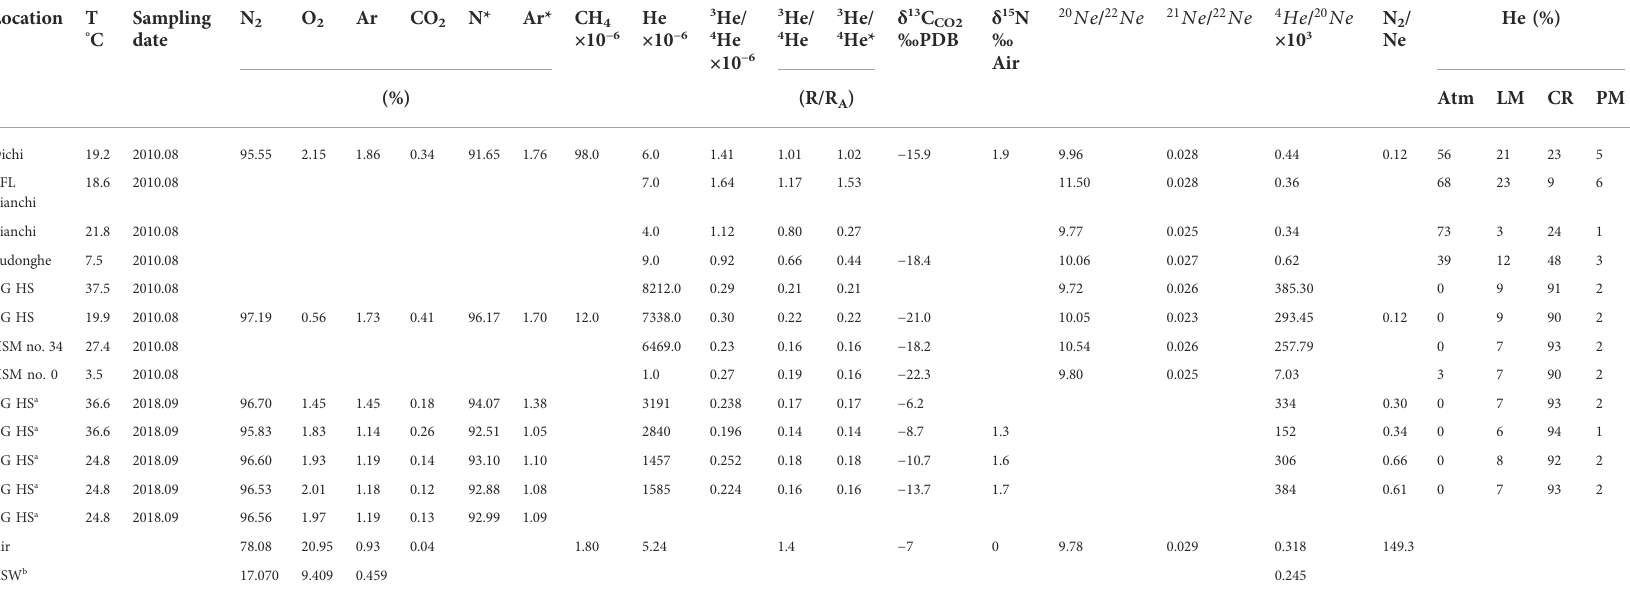
TABLE 2 Molecular and isotope compositions of gases from the springs and lakes in the Arxan volcanic region.